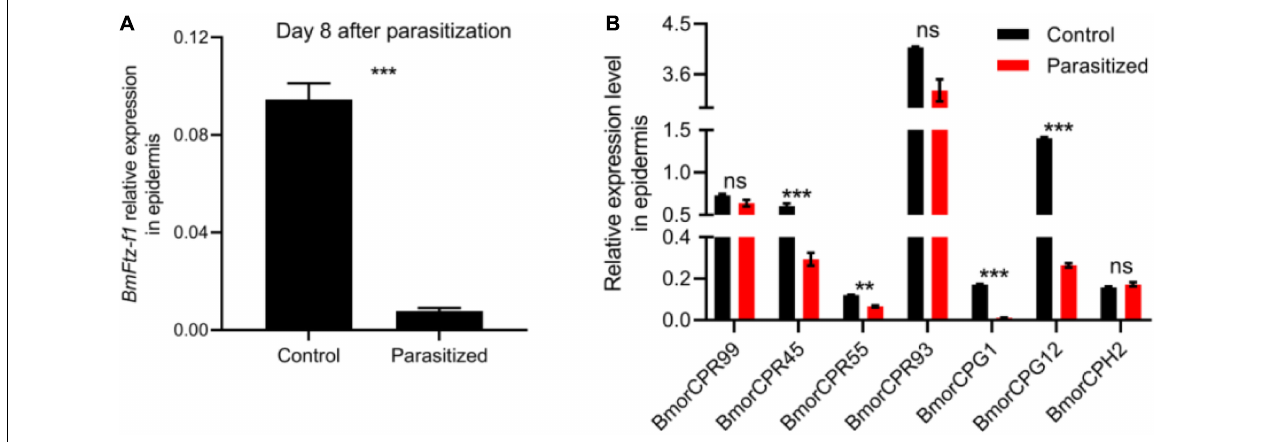
FIGURE 4 | The effect of E. japonica parasitoidism on expression of BmFtz-f1 and cuticular protein genes in host epidermis. (A) The expression level of BmFtz-f1 in host epidermis. (B) The expression levels of cuticular protein genes in host epidermis relative to BmActin3 . All the data were presented as mean ± SD with n = 3. Significance of the results was determined by the Student’s t -test; ** P < 0.01, *** P < 0.001, ns not